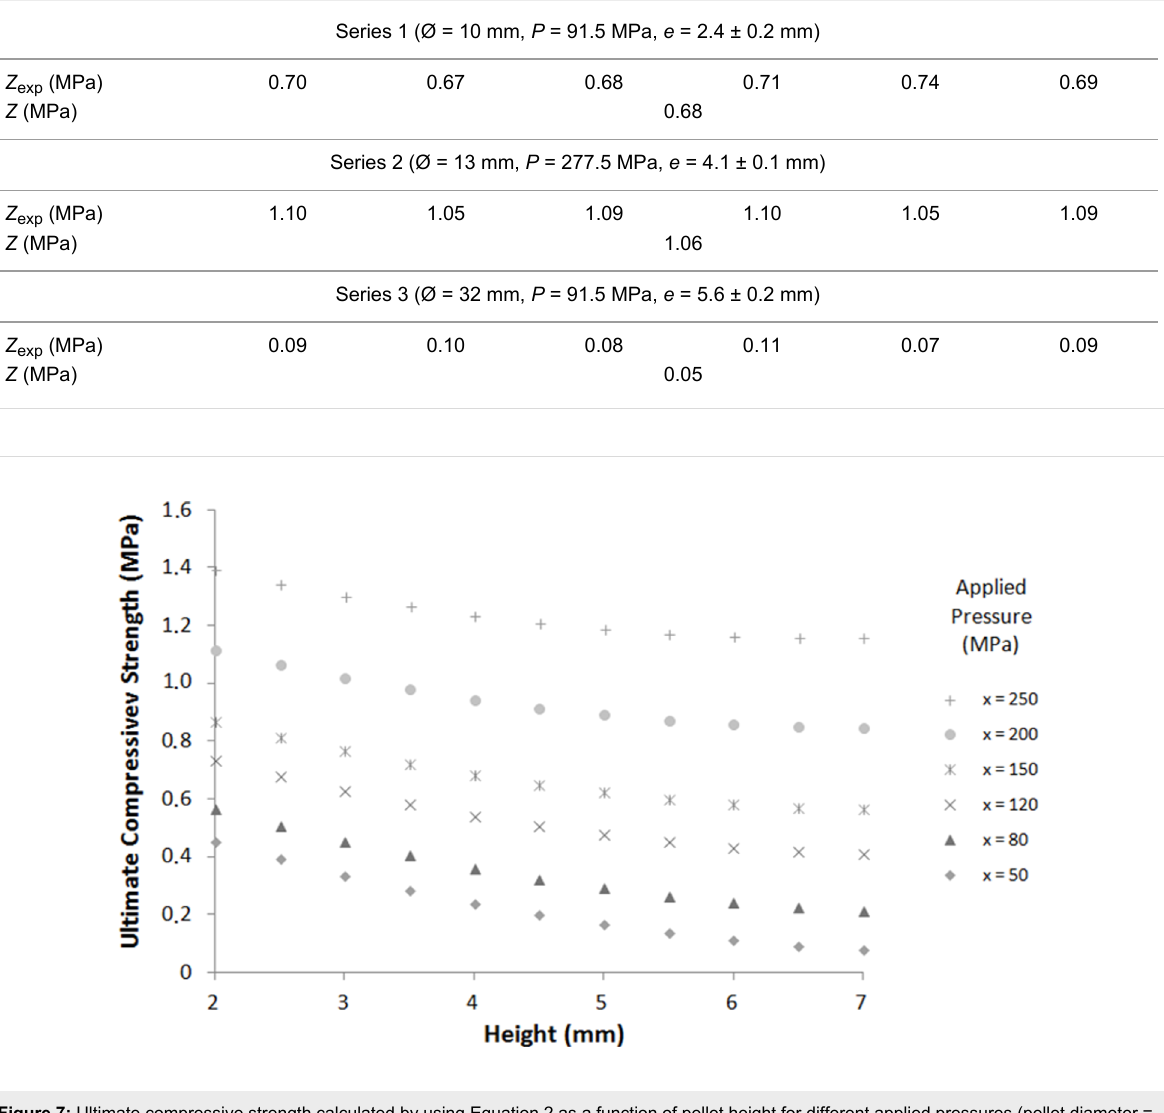
Table 3: Experimental and calculated ultimate compressive strengths for 3 series of 6 experimental tests (diametric compression tests). Z exp is the experimental and Z the calculated ultimate compressive strengths of the pellets, respectively.